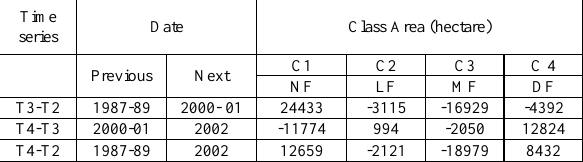
Table 2: Statistical summary of FCD